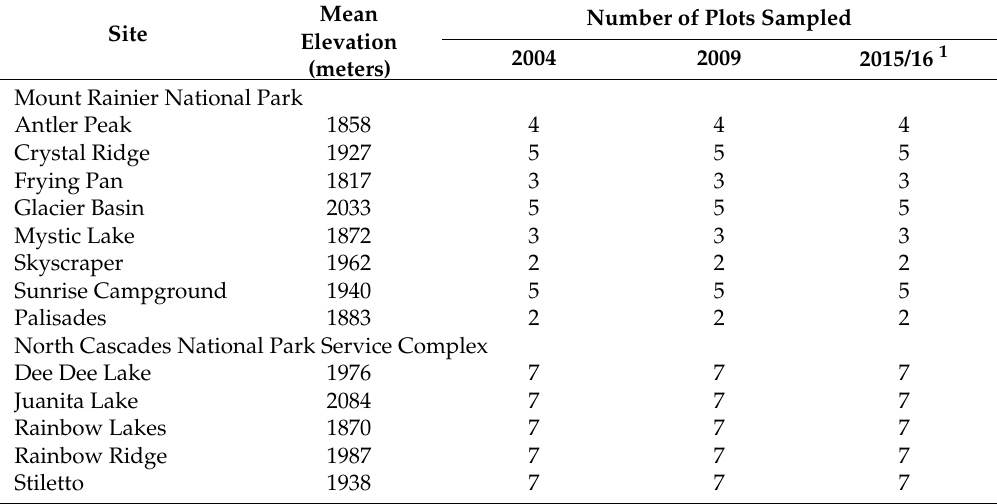
Table 1. Sample sites (primary sample units) and plots (secondary sample units) established at Mount Rainier National Park and North Cascades National Park Service